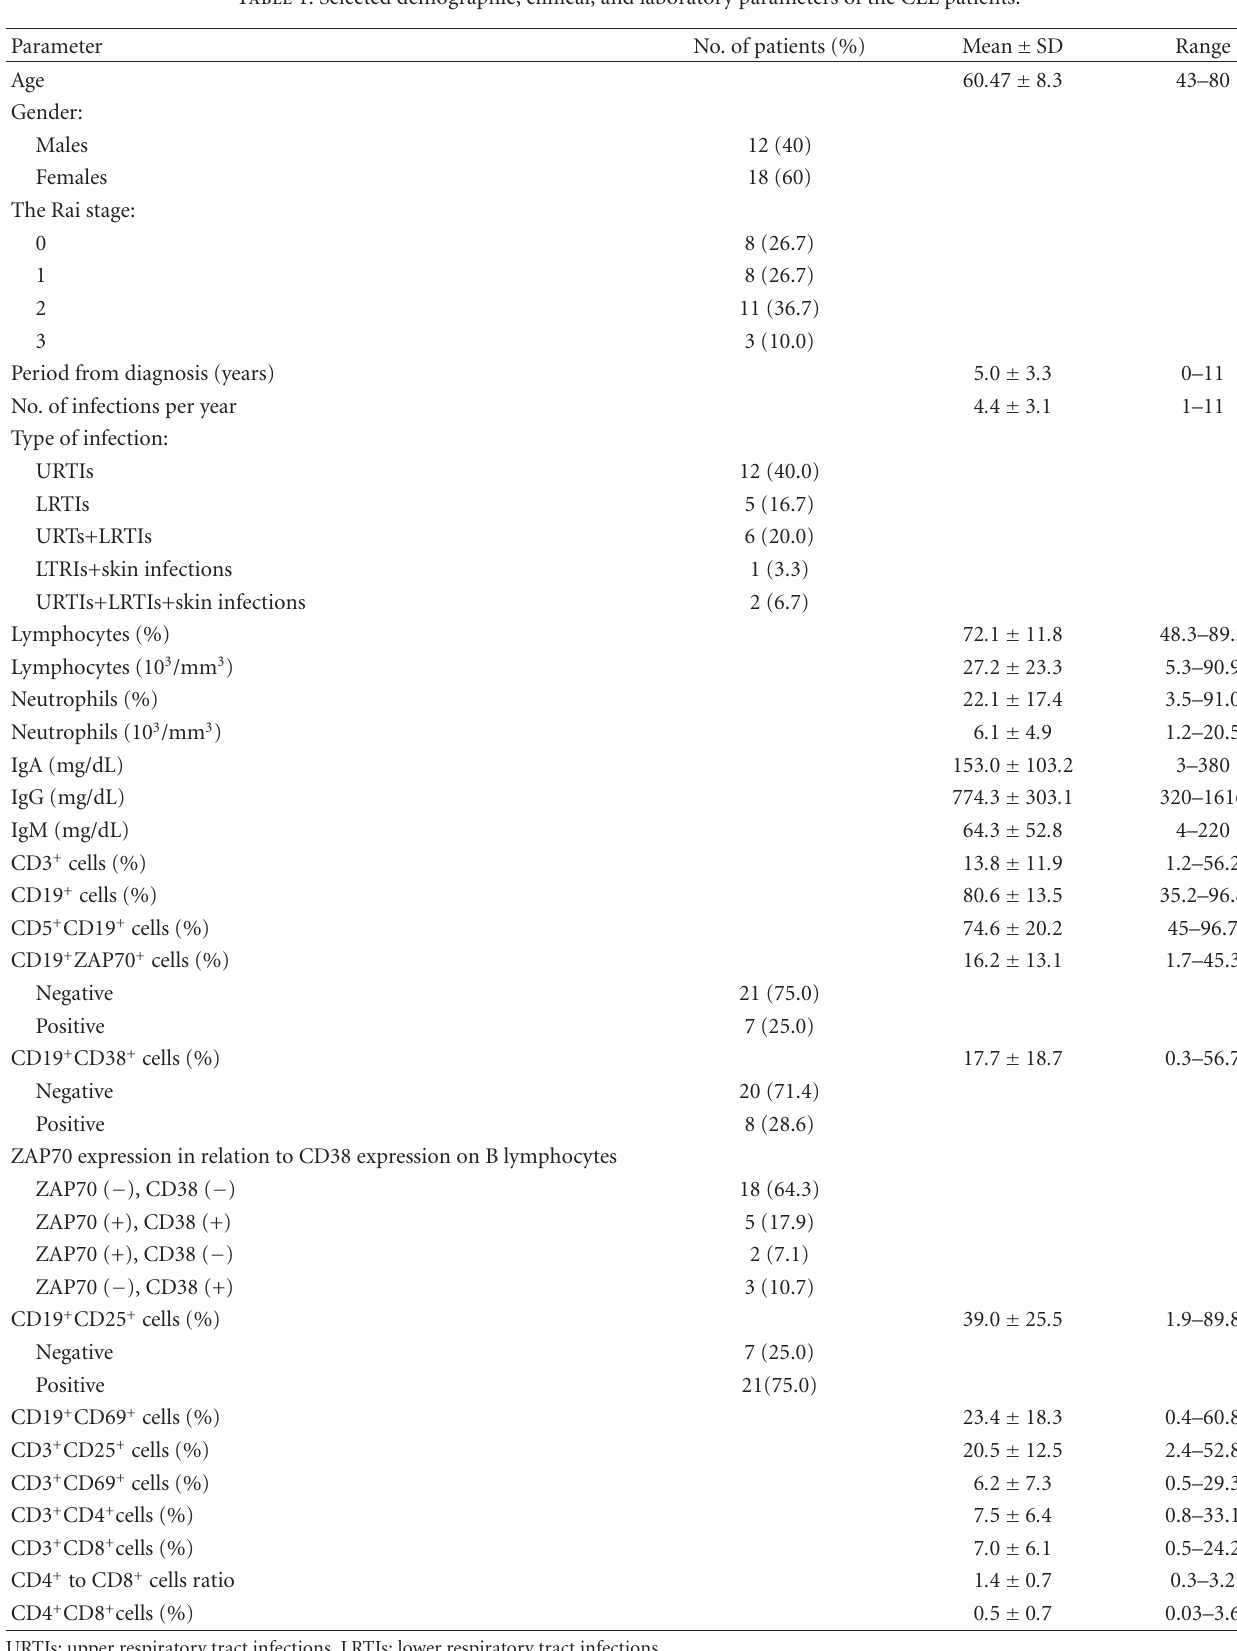
Table 1: Selected demographic, clinical, and laboratory parameters of the CLL